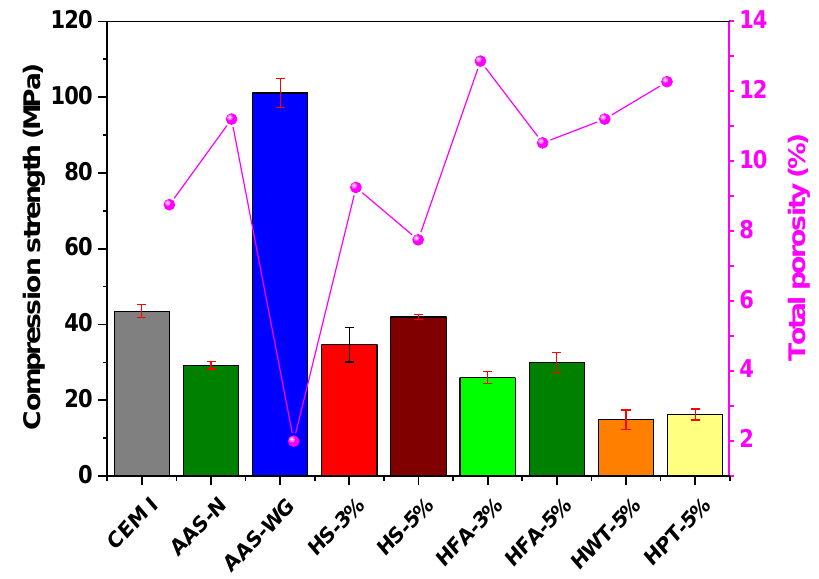
Figure 4. Relationship between compression strength and total porosity at 28 days of curing for all systems evaluated .